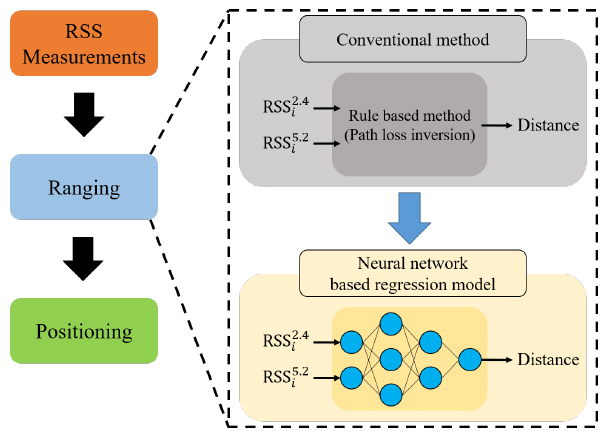
Figure 3. Proposed hybrid range-based localization